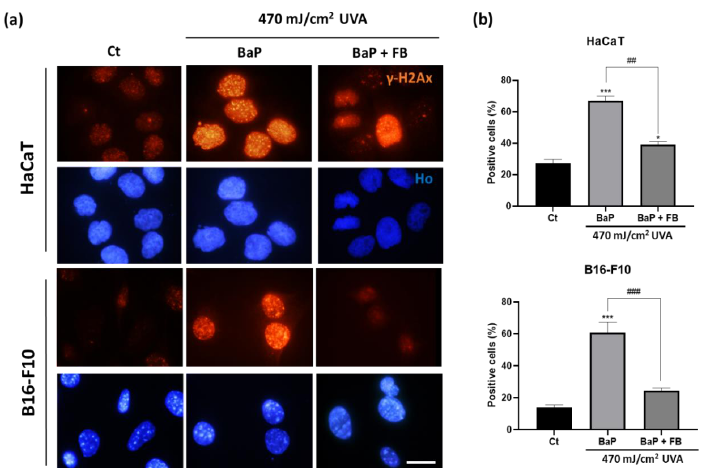
Figure 6. γH2AX localization and positiveness in HaCaT and B16 -F10 cells after treatments. Cells incubated with BaP or BaP + FB for 48 h and immediately exposed to 470 mJ/cm 2 of UVA light. γH2AX expression was evaluated 24 h after light exposure. ( a ) Fluorescence microscopy images of positive and negative γH2AX cells. Cells treated with BaP and then exposed to UVA light displayed increased γH2AX expression levels. Cells treated FB + BaP and subsequently exposed to UVA showed a similar percentage of γH2AX -positive nuclei at in the case of control cells. Scale bar: 20 µm. ( b ) Quantification of positive γH2AX cells in both cell lines. The results showed a significant increase in cells treated with BaP and exposed to UVA light. However, cells treated FB during BaP exposition prior to UVA light showed a significant decrease of positive cells. Error bars denote ± S.E.M. ( n = 3, one-way ANOVA *: p < 0.05; ***: p < 0.001; and n = 3, t -test ##: p < 0.01; ###: p < 0.001). The 8-OHdG marker is routinely used as an indicator of oxidative stress and nucleic acid damage triggered by UV irradiation. Because of the fast capacity of cells to repair this oxidized derivative, short time points after UVA light exposure (1 h and 5 h) were selected to evaluate the presence of 8-OHdG by indirect immunofluorescence [44]. Untreated (con- trol) cells displayed low basal levels of 8-OHdG mostly localized in the cytoplasm (Figure 7a), suggesting that nuclear DNA remains protected from oxidation in resting conditions. In response to single treatment with BaP or with UVA light, despite the nuclear levels of 8-OHdG were significantly increased 1 h after the treatment with either agent in both cell lines, they were completely reverted after 5 h in HaCaT cells, but not in B16-F10 cells (Fig- ure S8). The combined treatment with BaP followed by UVA light irradiation induced abundant nuclear accumulation of 8-OHdG in both cell lines, suggesting profound ge- nomic damage. This result was particularly remarkable shortly after the treatment (1 h) (Figure 7a,c), indicating that nucleic acid oxidation occurs at early timepoints after the administration of the combined treatment. Interestingly, we observed a decrease in the nuclear levels of 8-OHdG with time (results are shown 5 h after treatment) (Figure 7b,c), especially in HaCaT cells, suggesting that rapidly activated DNA repair mechanisms could naturally contribute to partially repair the damage caused. Although partially re- duced, 5 h after the sequential treatment nuclear levels of 8-OHdG still remained signifi- cantly higher than in the control in both cell lines. It is worth noting that a unique